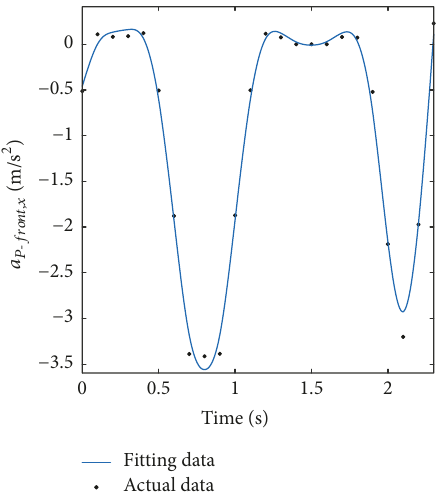
Figure 16: Acceleration curve of CL-car in the positive direction of Y-axis with time.